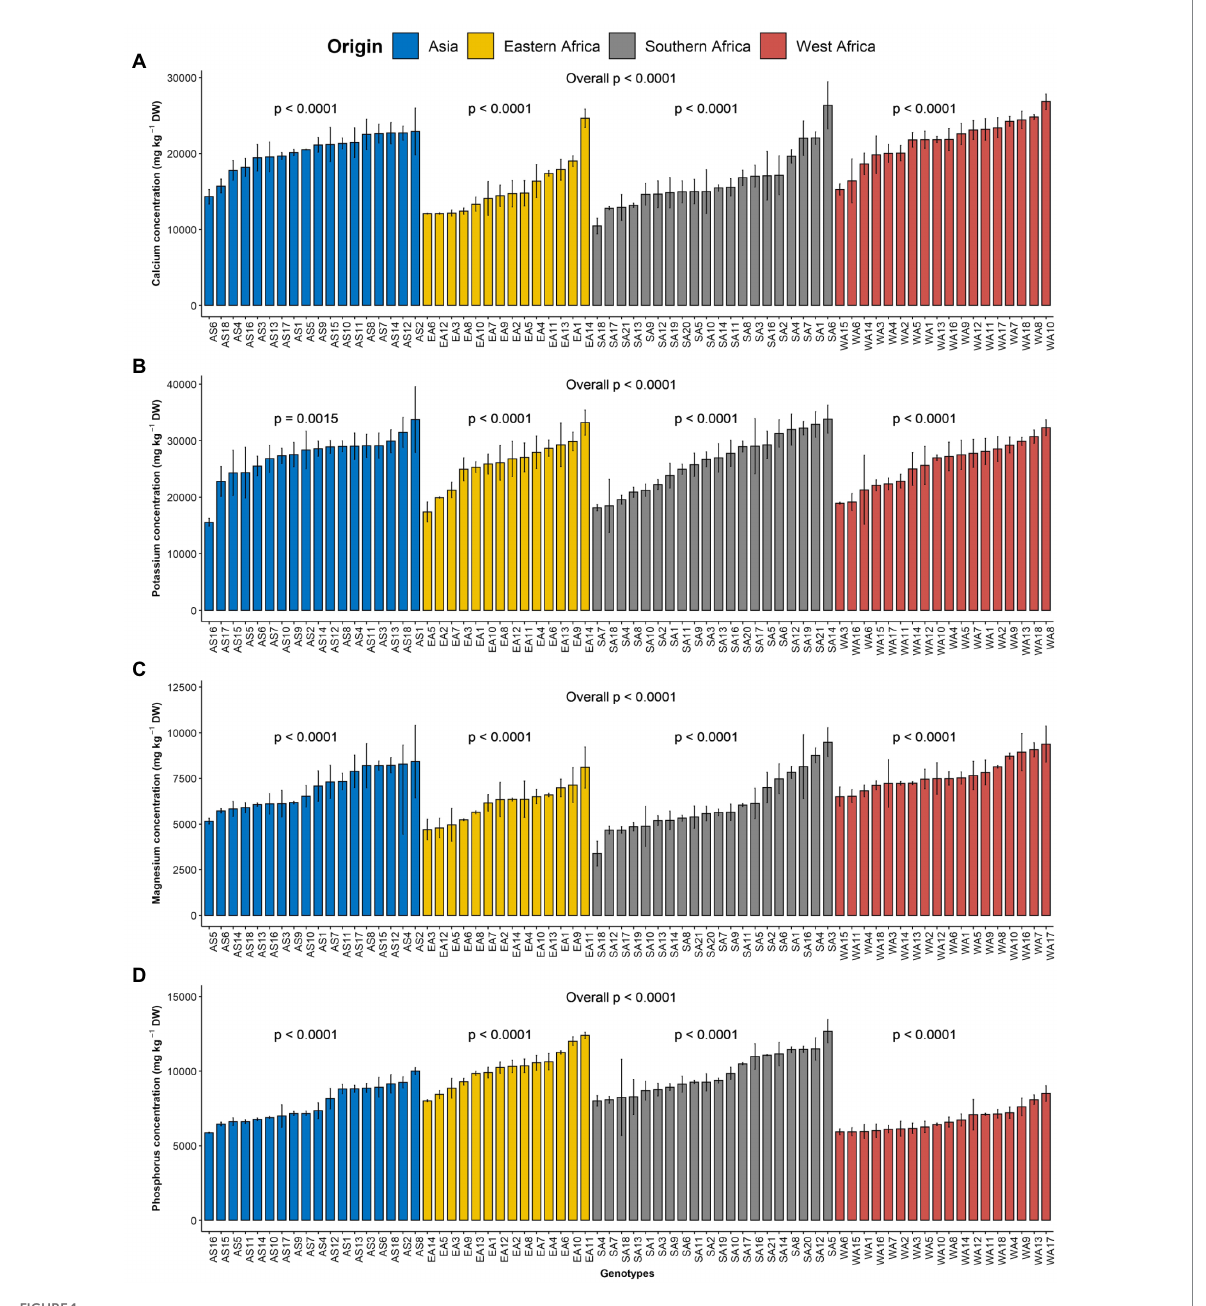
FIGURE 1 Variation in leaf macroelements content among 70 advanced lines of Gynandropsis gynandra evaluated across years (2020 and 2021). (A) Calcium content; (B) Potassium content; (C) Magnesium content and (D) Phosphorus content. Bar plots are means and error bars represent standard errors across years ( n =